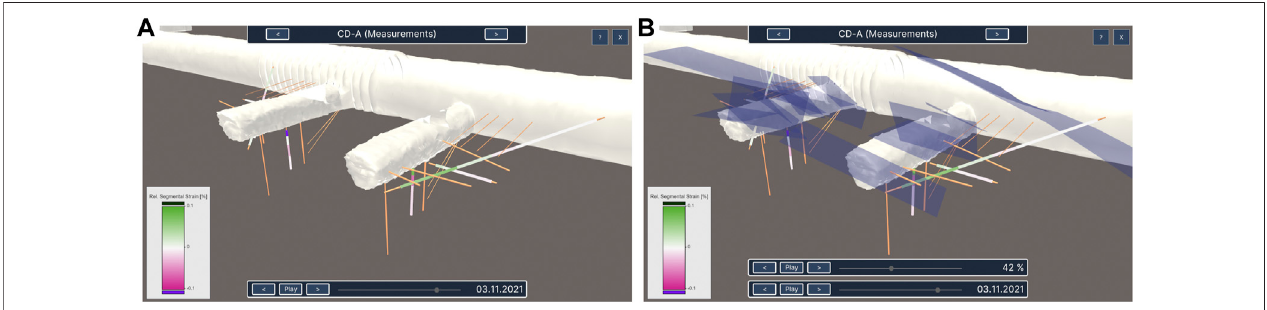
FIGURE 7 | The in-scene visualisation of measurements exemplary for the extensometer measurements in the scope of the Cyclic Deformation Experiment (A) without additional context data and (B) with the local fault zones.